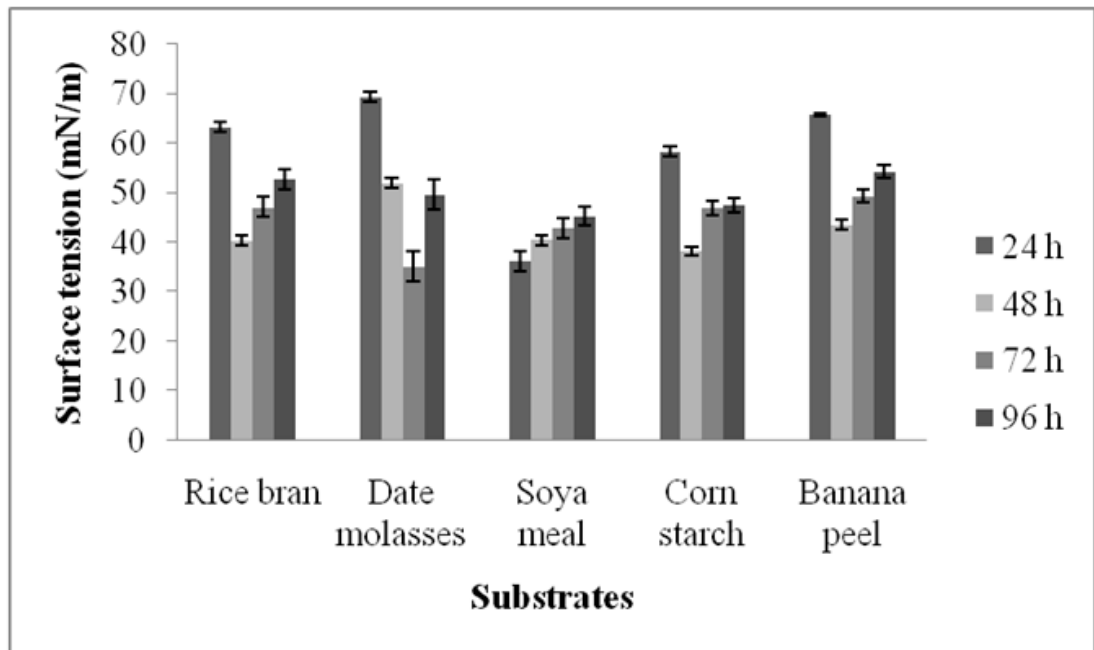
Figure 2. Effect of various substrates on biosurfactant production by B. subtilis strain Al-Dhabi-130. Figure 2. E ff ect of various substrates on biosurfactant production by B. subtilis strain